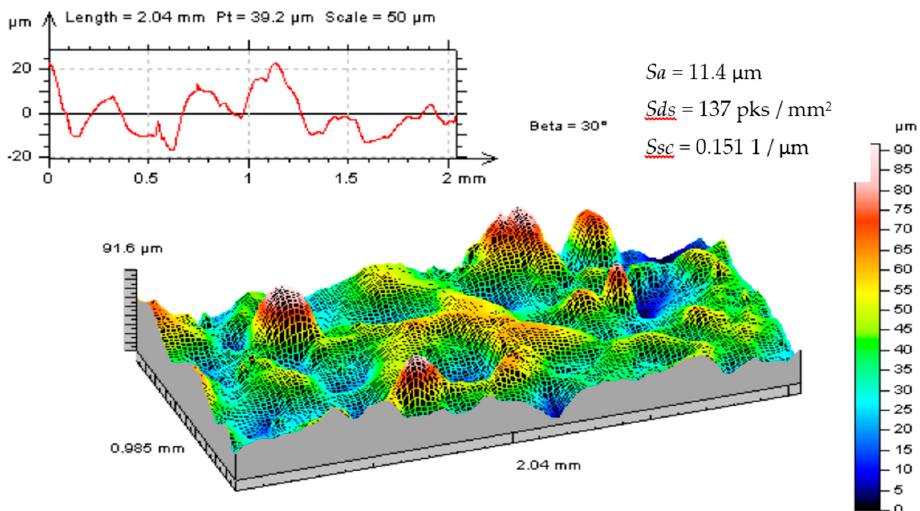
Figure 2. Surface texture after EDM ( I c = 3 A, t on = 150 µ s).